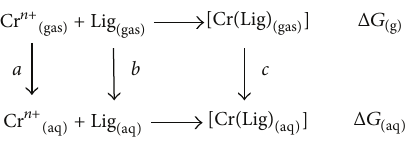
Figure 3: Thermodynamic cycle.